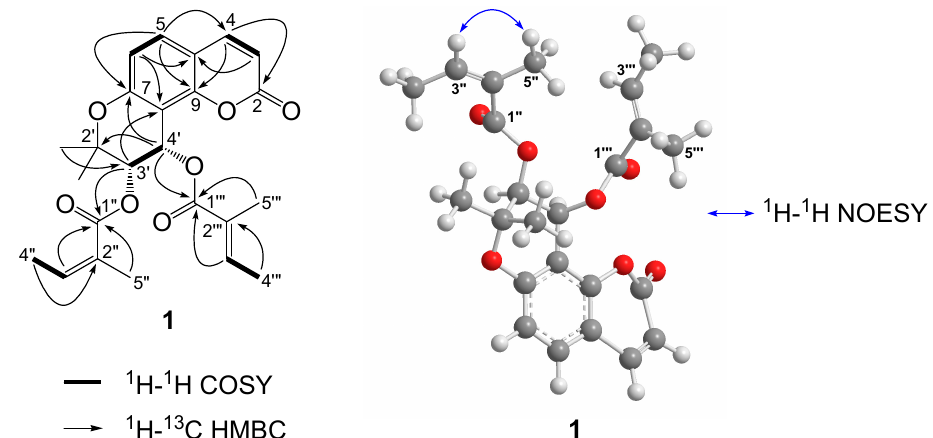
Figure 2. Key COSY, HMBC, and NOESY correlations of compound 1 . MM2 energy-minimized 3D structure acquired by a Chem3D Ultra software.